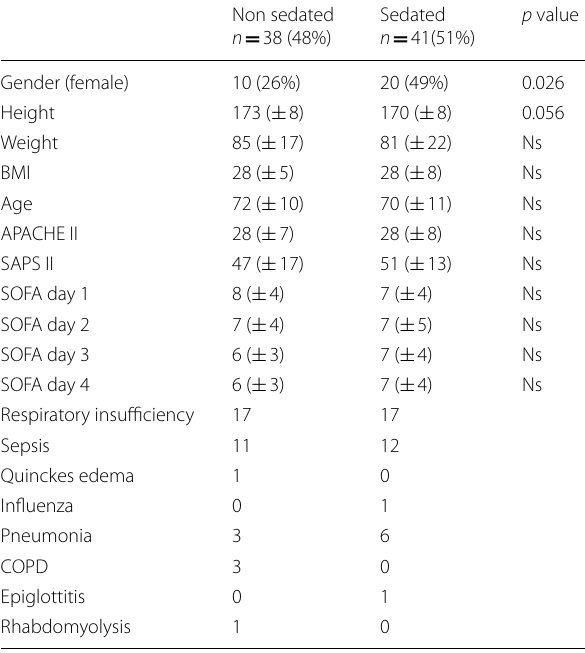
Table 1 Baseline